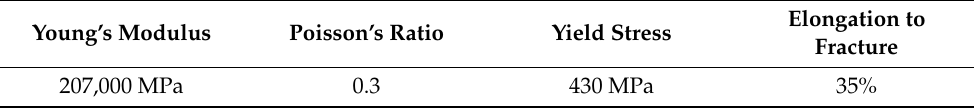
Table 2. Mechanical characteristics of P264GH. Table 3. Chemical composition of P264GH.